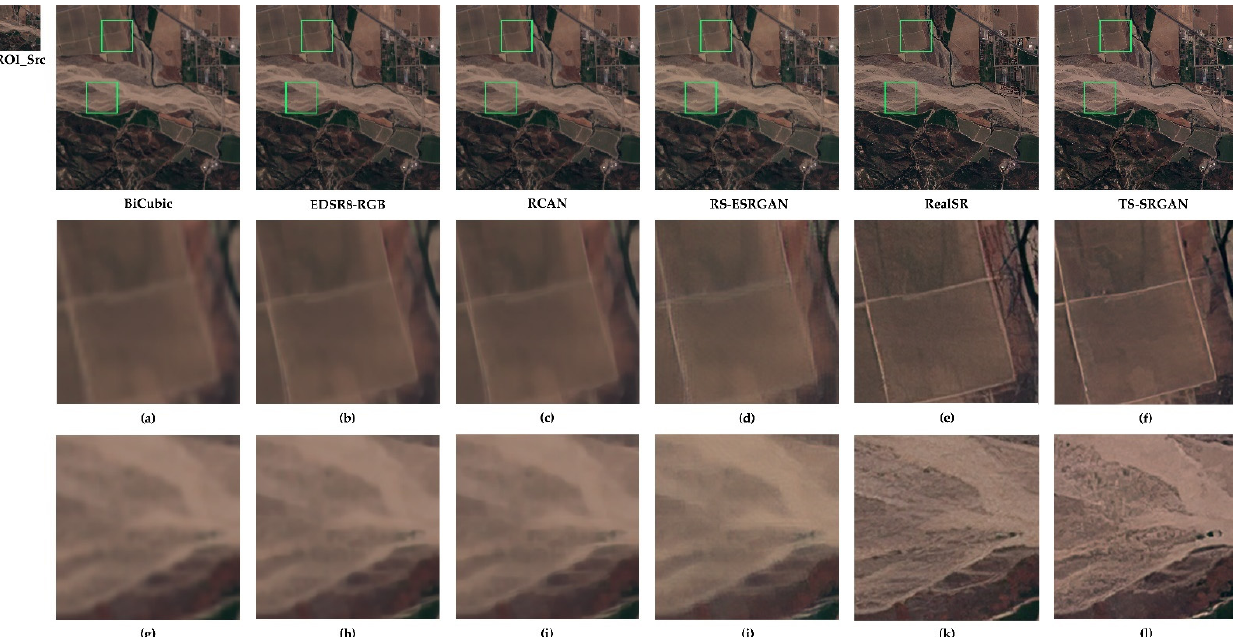
Figure 19. Comparison of visual effects of the generated images of the region containing residential houses. NR-IQA of images (NIQE, BRISQUE, PIQE): BiCubic (6.26, 53.22, 100.00), EDSR8-RGB (4.82, 45.85, 74.28), RCAN (3.96, 45.61, 71.41), RS-ESRGAN (3.08, 22.47, 20.85), RealSR (3.12, 27.19, 15.42), TS-SRGAN (2.32, 18.27, 13.99). The subfigures ( a – l ) in the figure represent an enlarged view of the local details in the green boxes in the generated image.